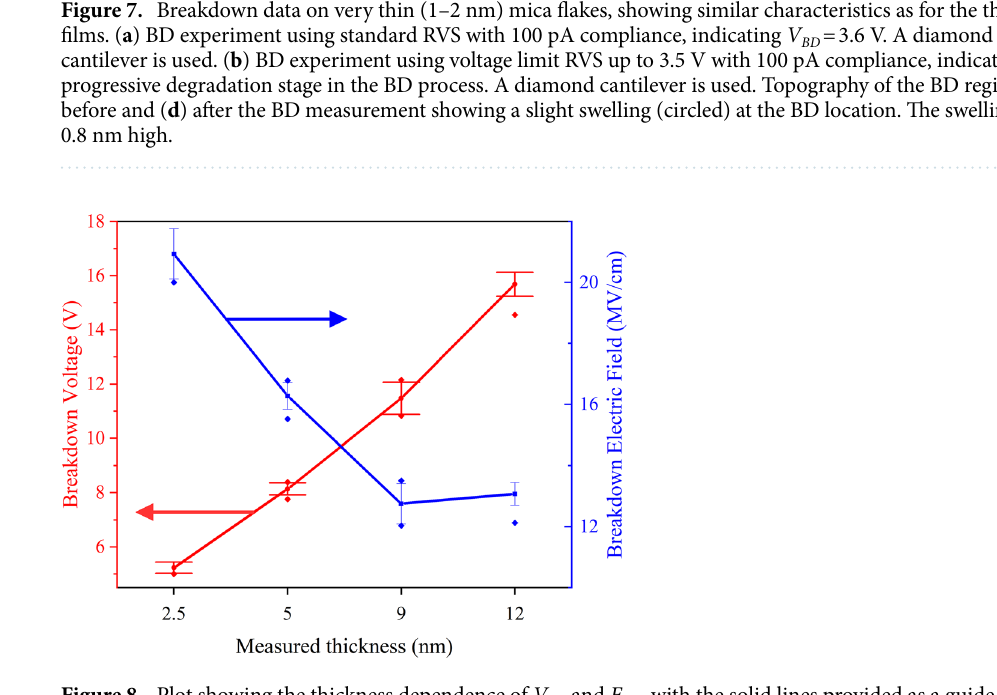
Figure 8. Plot showing the thickness dependence of V BD and E BD , with the solid lines provided as a guide to the eye. The error bars indicate the spread of values measured with different tips and on different